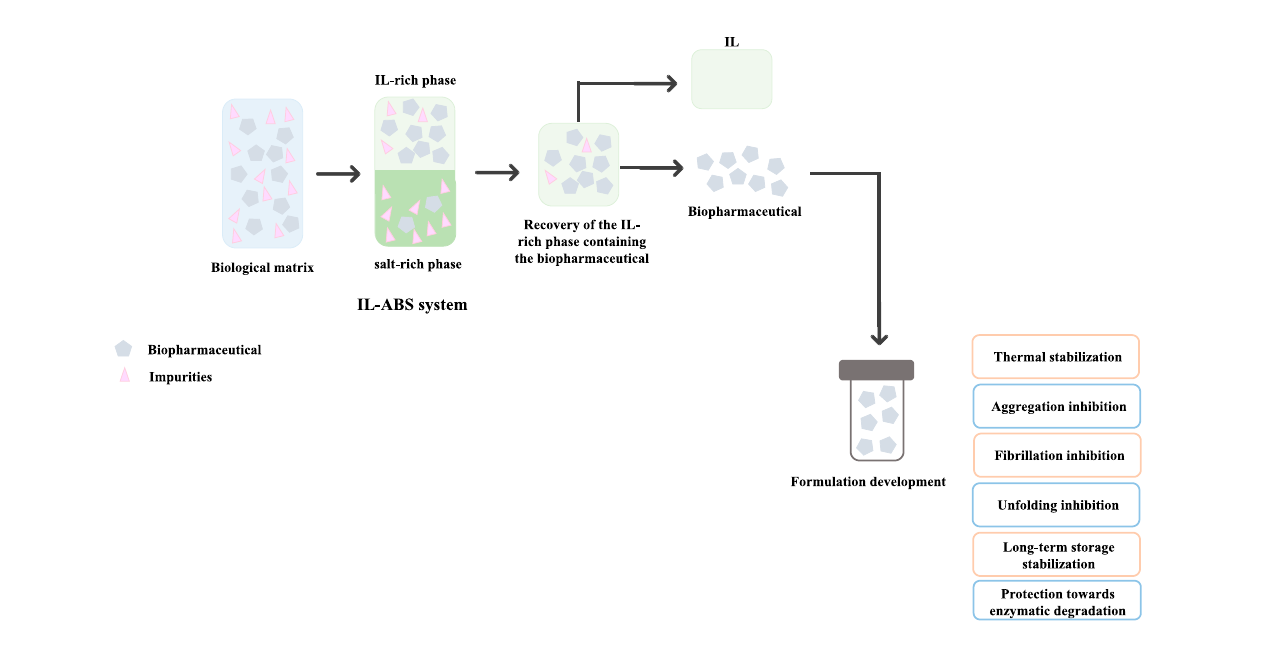
FIGURE 7 Representative integration of biopharmaceuticals ’ downstream processing and formulation development stages using IL-based